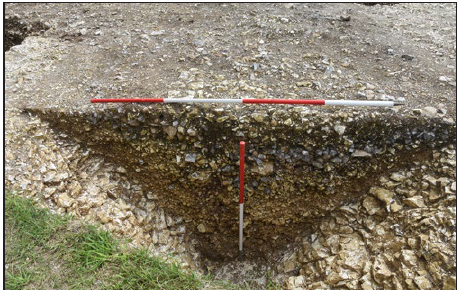
Figure 9: Section through the IA ditch in Tr17, looking east, note the large amount of burnt flint tipped into the ditch from the south. (Scales 0.5 m divisions). Photo: MBR.